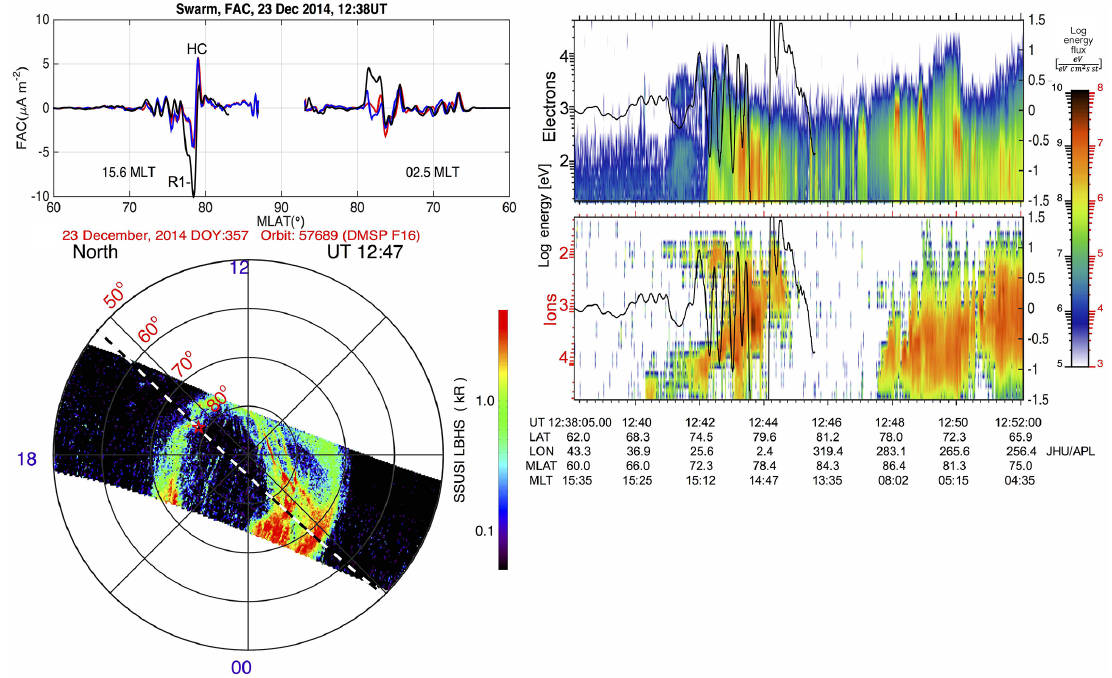
Figure 9. Same as Fig. 8 but for subsequent